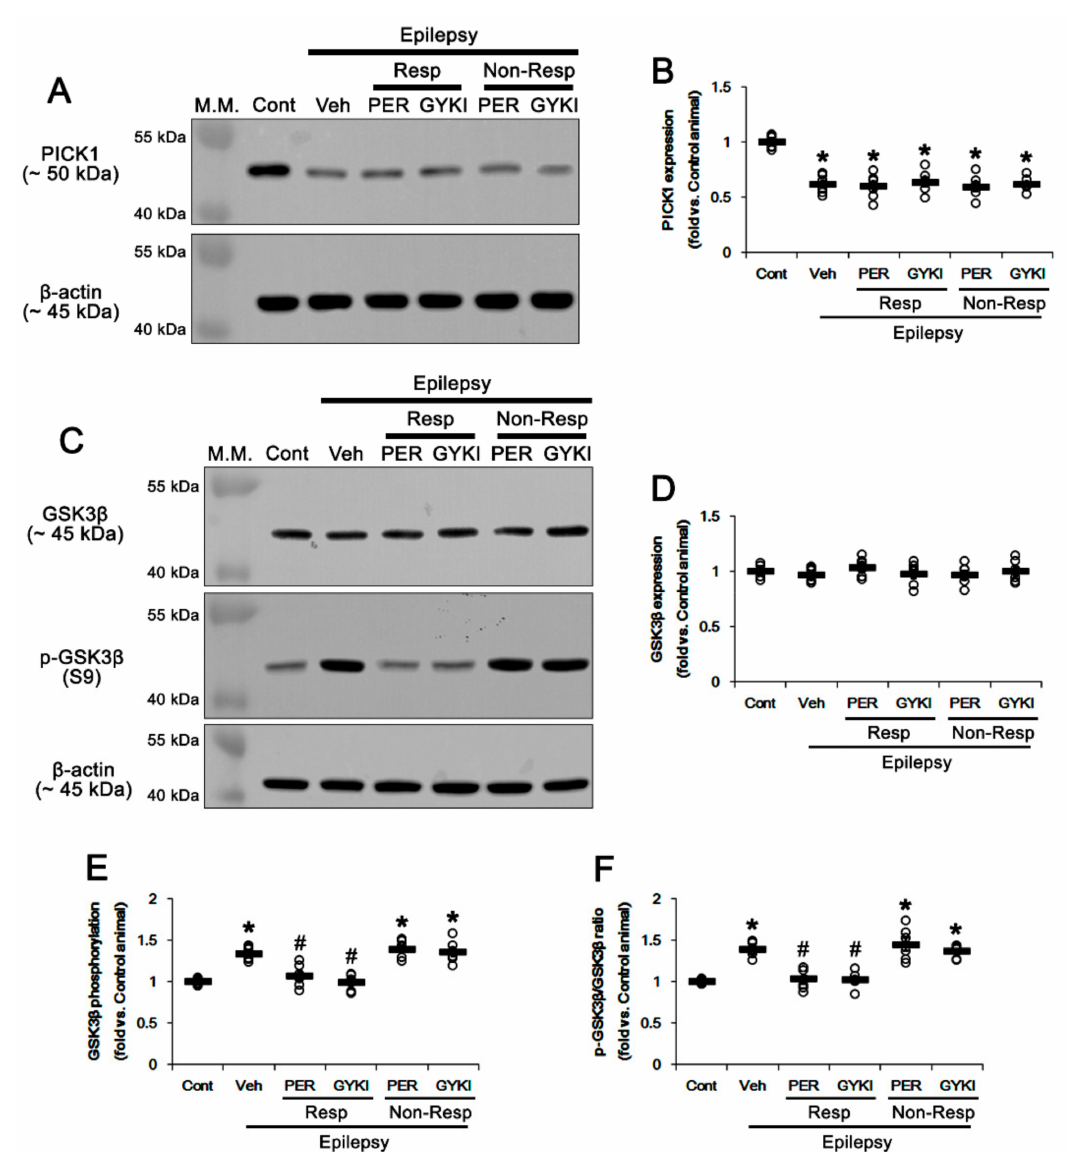
Figure 6. The effects of perampanel (PER) and GYKI 52466 (GYKI) on protein interacting with C kinase 1 (PICK1) expression and glycogen synthase kinase 3 β (GSK3 β ) expression and its phosphorylation in chronic epilepsy rats. ( A , B ) Representative images for Western blot of PICK1 expression ( A ) and quantifications of PICK1 expression ( B ) in the hippocampal tissues. ( C – F ) Representative images for Western blot of GSK3 β expression and its phosphorylation ( C ) and quantifications of GSK3 β ( D ), p-GSK3 β S9 ( E ), and p-GSK3 β S9/GSK3 β ratio ( F ) in the hippocampal tissues. Open circles indicate each individual value. Horizontal bars indicate mean value. Error bars indicate SEM ( *, # p < 0.05 vs. control (Cont) and vehicle (Veh)-treated animals, respectively; one-way ANOVA with post hoc Bonferroni’s multiple